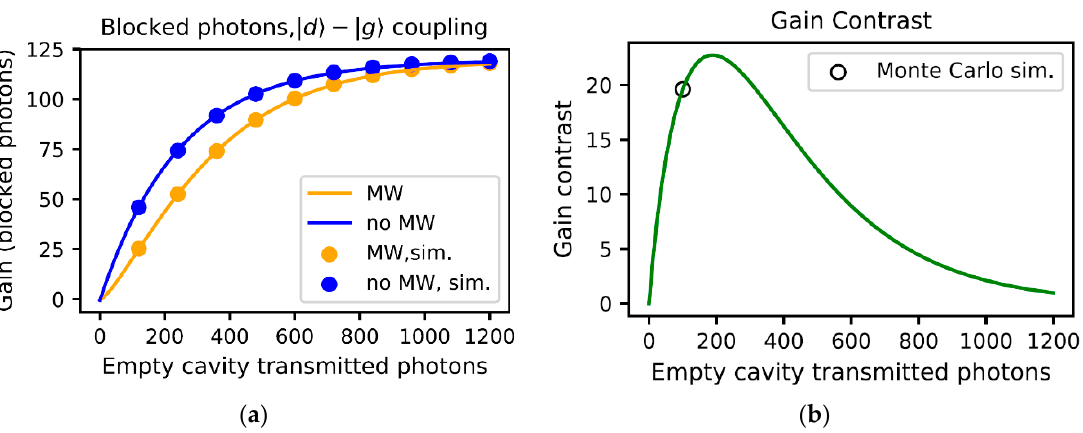
Figure 3. ( a ) Detector gain when a microwave photon is not present (blue) and when a microwave photon is present (orange). The dots are the results of the Monte Carlo simulation, and the solid lines are obtained by direct numerical integration of the master equation. ( b ) Gain contrast. The black circle shows the gain contrast for 100 photons obtained by the Monte Carlo simulation.